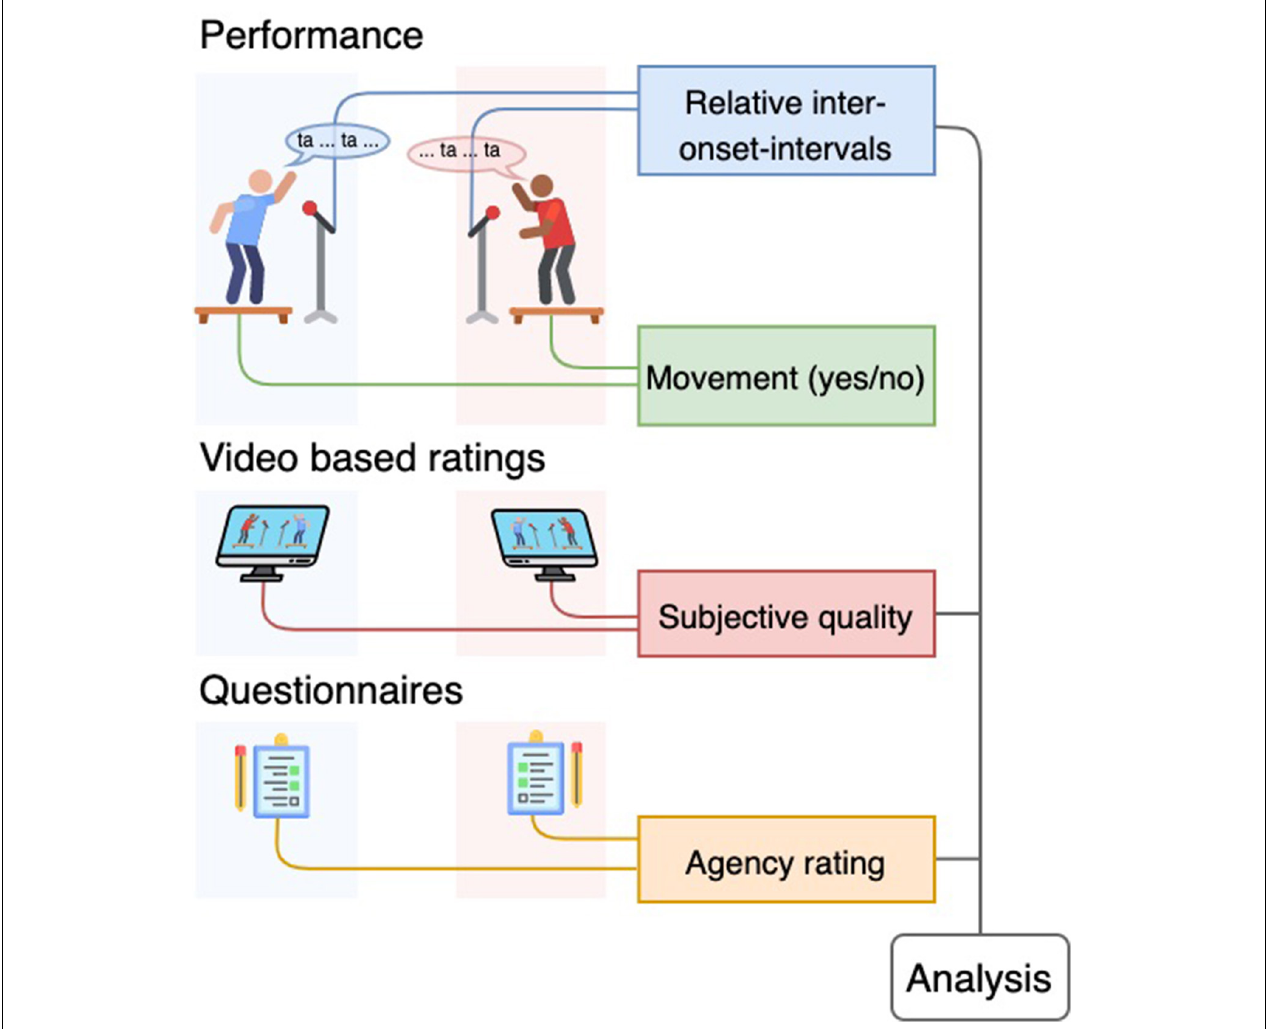
FIGURE 2 | Experimental procedure. Each experiment has three parts. The performance is followed by video based ratings and questionnaires. During performance the participants are allowed to move or not, which is checked by the movement outcome. Other measures are combined in the